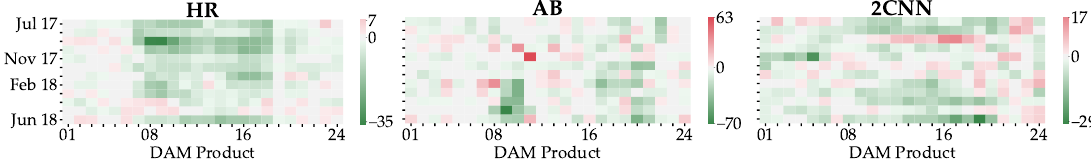
Figure 5. Heatmaps showing the %RMSE for each month of the test set and each hour denominated DAM contract, resulting from including EMA ( s = 2), MOM ( n = 58), and ROC ( n = 49) features with HR, AB, and 2CNN models respectively. Negative values ( green ) indicate a reduction in forecast error, while positive values ( red ) indicate an increase in forecast